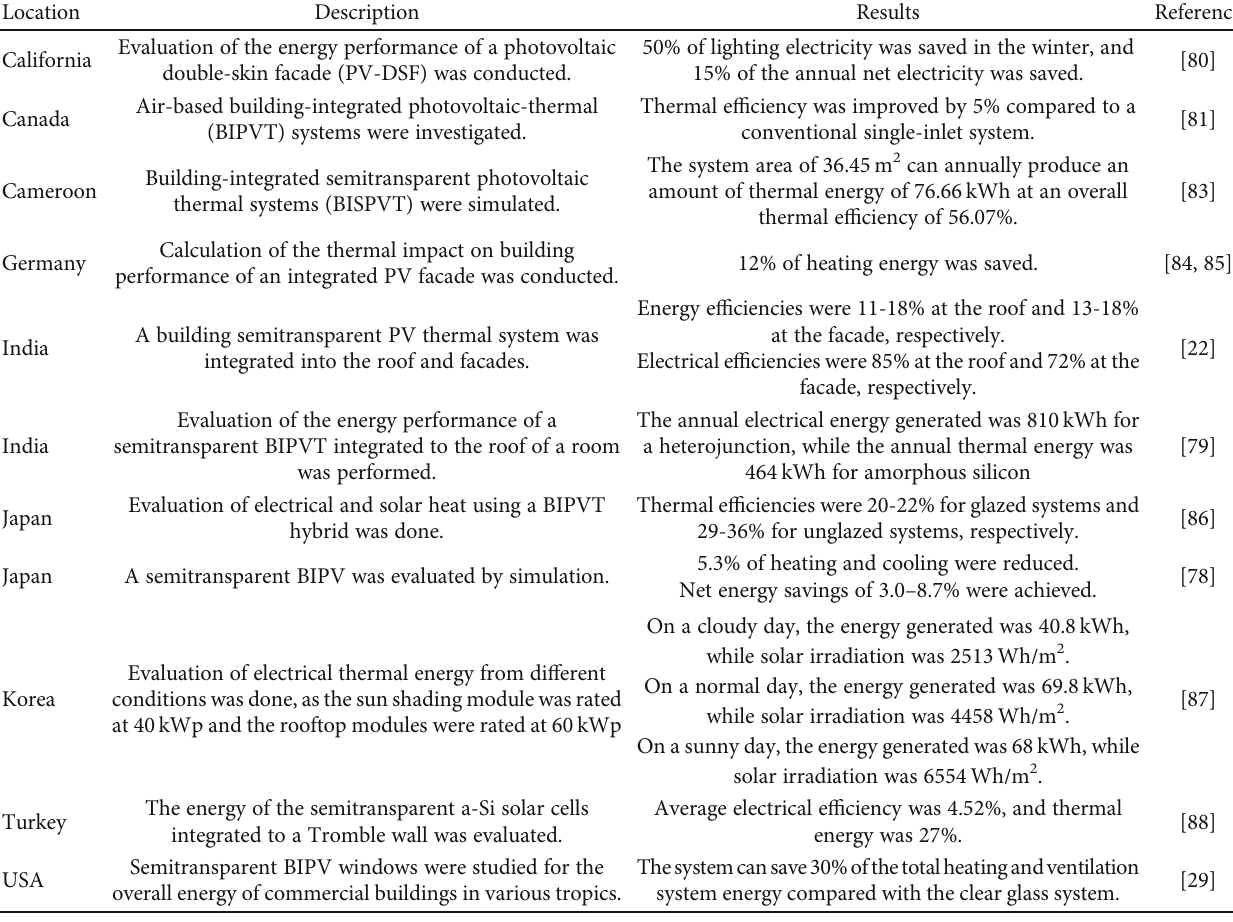
Table 4: Electrical and thermal properties of semitransparent BIPV: case studies from di ff erent